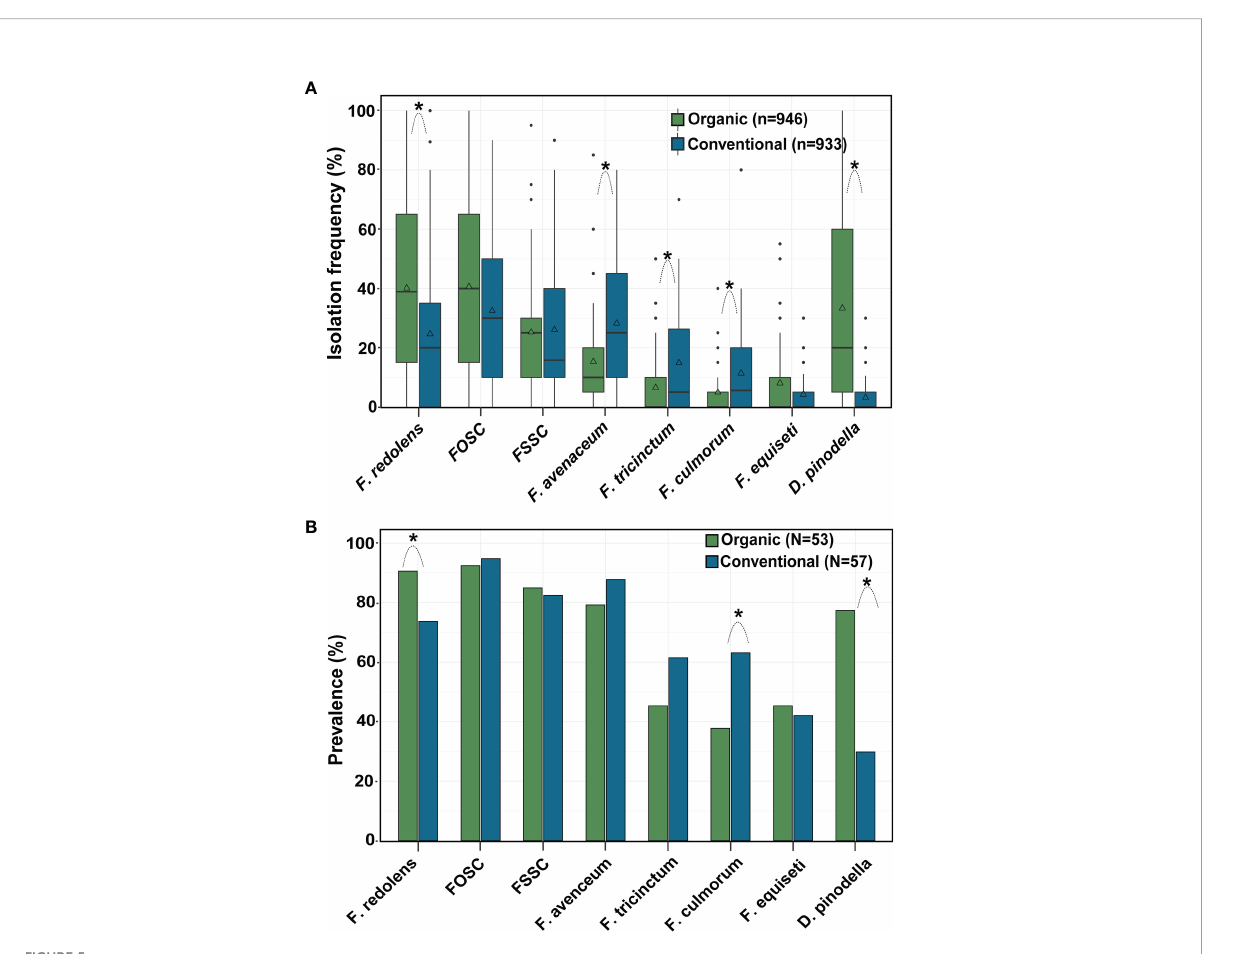
FIGURE 5 Effect of management system on (A) isolation frequency (%) and (B) prevalence (% fi elds yielding a given species) of the eight most common fungal species recovered from faba bean roots. Asterisks indicate signi fi cant differences (P < 0.05) between organic and conventional fi elds for each fungal species separately (Tukey-adjusted pairwise LSMeans comparisons). n = number of roots, N = number of fi elds evaluated. The horizontal line in the boxplot shows the median value, the bottom and tops of the box the 25th and 75th percentiles and the vertical lines the minimum and maximum values, outliers as single points. Mean values are marked with